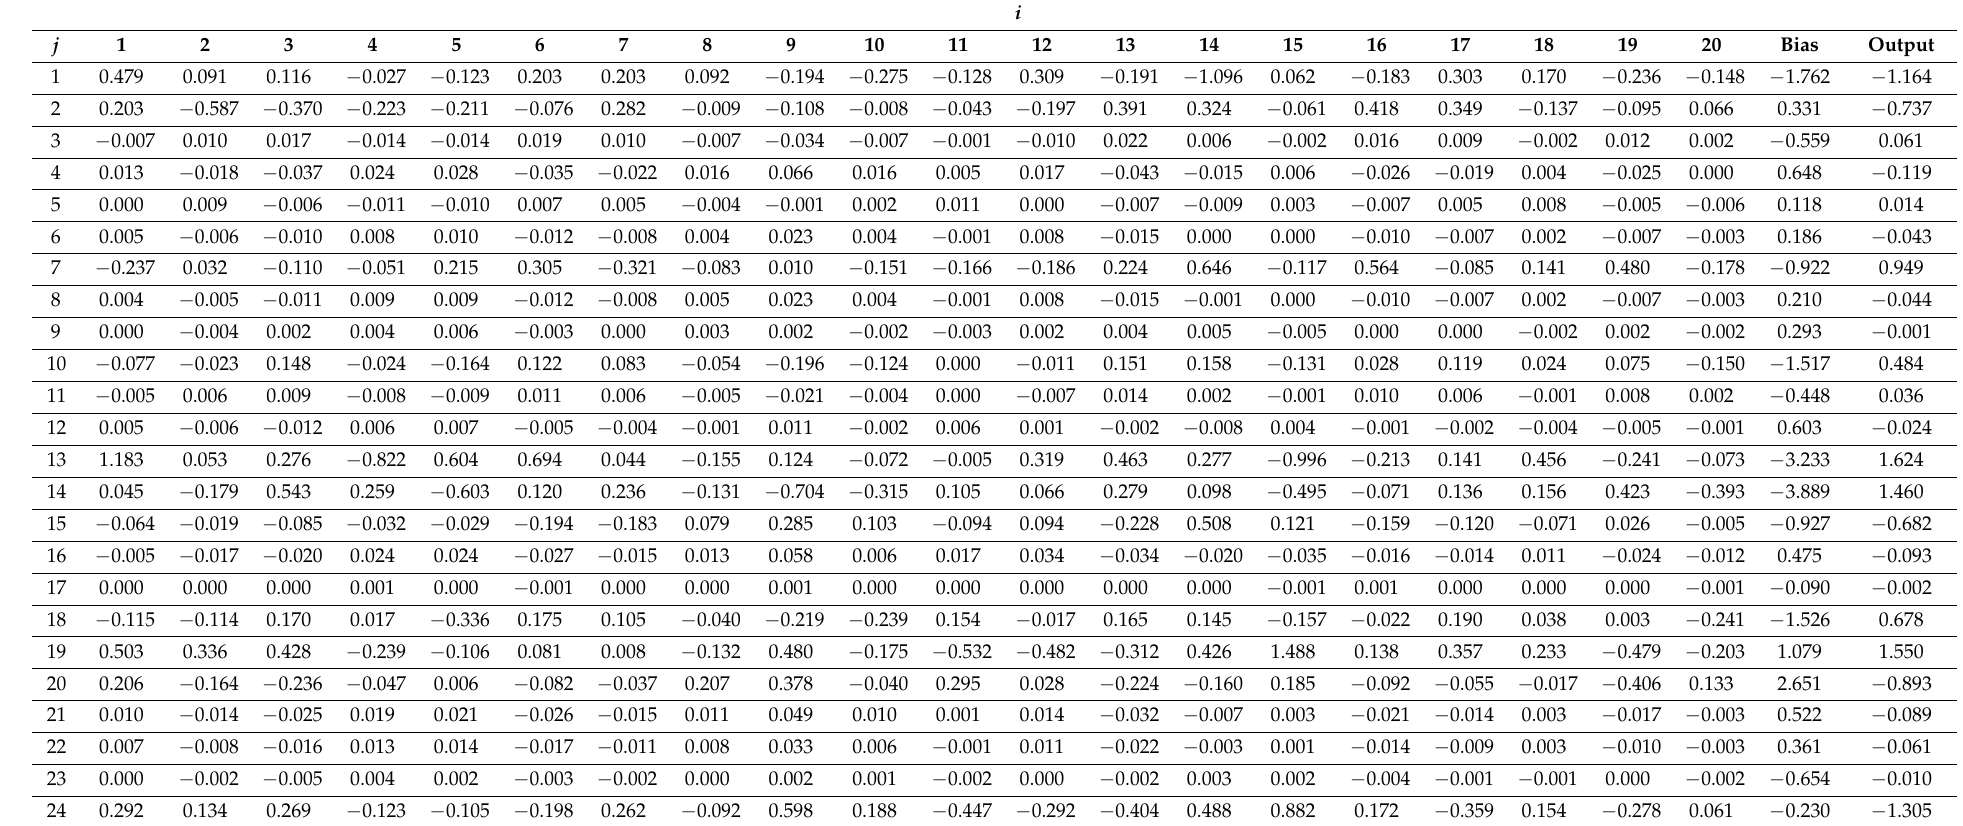
Table A3. Weights of Hidden Layer of